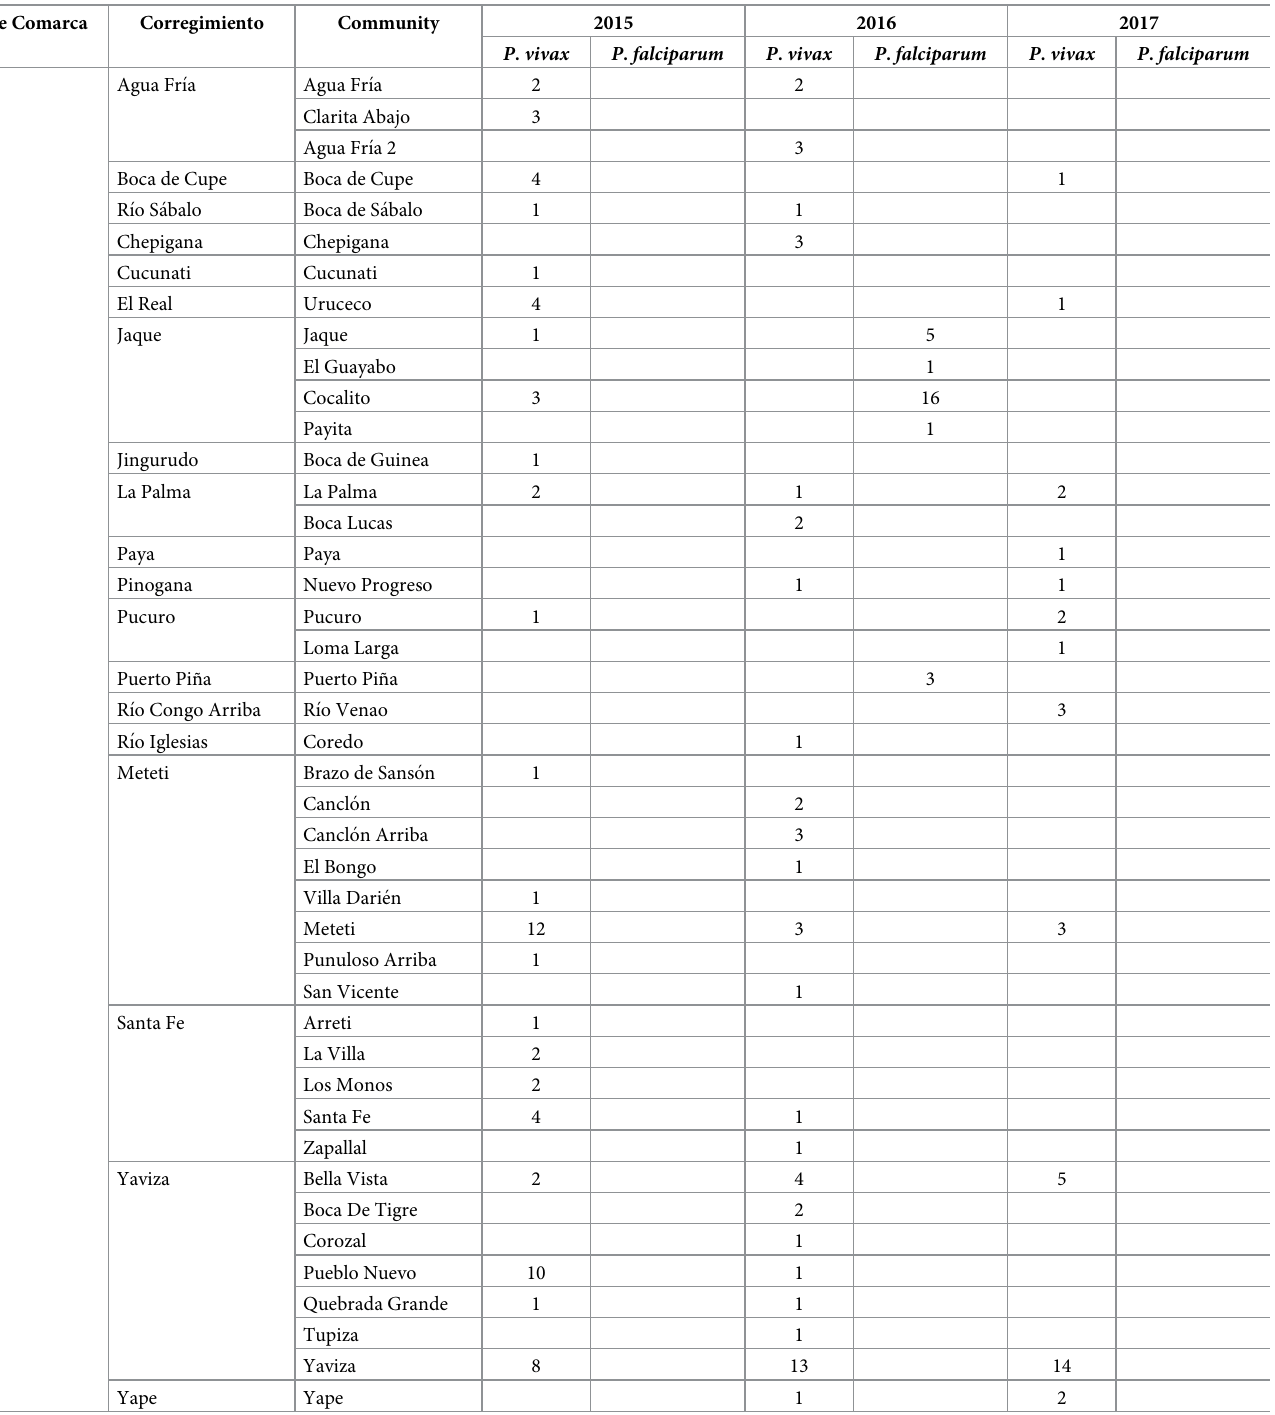
Table 1. Distribution of cases malaria by corregimientos and community in Darien Region. 2015 to 2017. Province